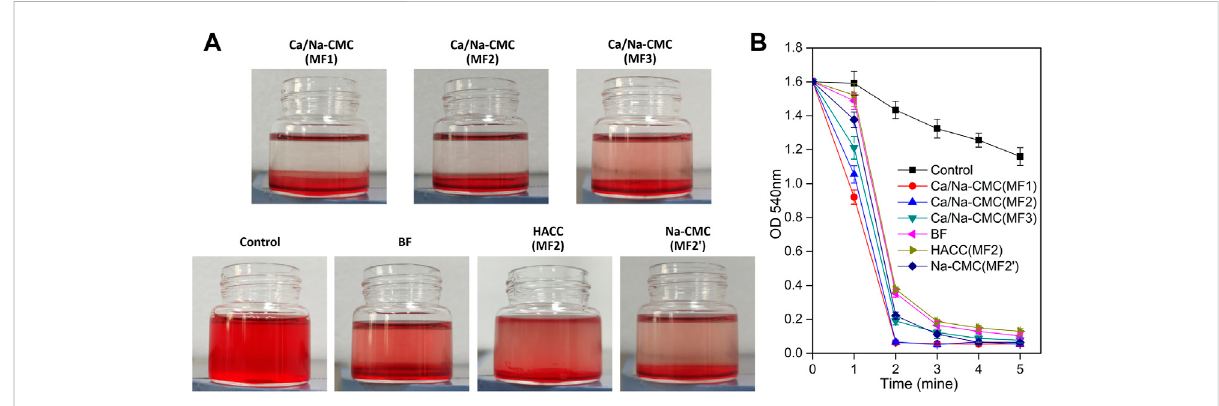
FIGURE 5 Blood clotting ef fi ciency. (A) Photographs of the vials after 2 min clotting with the BF and multilayer fi lms with different top layers: MF1 − MF3withCa/Na-CMCtoplayer,MF2withHACCtoplayer,MF2 ′ withNa-CMC top layer. (B) Bloodclottingef fi ciencydeterminedbymeasuring hemoglobin absorbance (540 nm) from RBCs not involved in